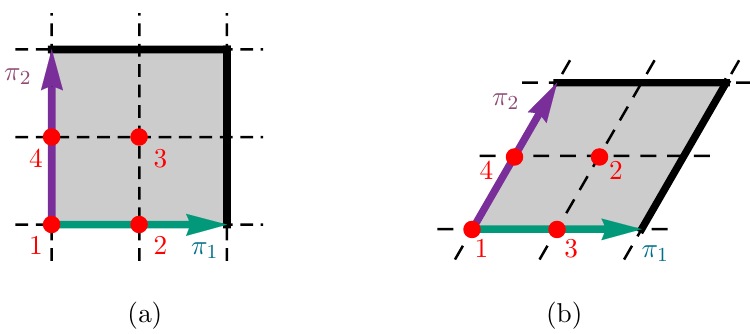
Figure 1 . Lattice con(cid:12)guration for a square (a) and hexagonal (b) two-torus T 2 indicate a fundamental cell in the two-torus lattice, while the coloured vectors represent the basis one-cycles (cid:25) 2 i (cid:0) 1 ; (cid:25) 2 i spanning the fundamental cell (with the two-torus index i suppressed in the following). The red points correspond to Z 2 (cid:12)xed points on T 2 , whose labels match the indices of the roots of F ( x; v ) in equation (2.8). An anti-holomorphic involution keeping the one-cycle (cid:25) 1 (cid:12)xed